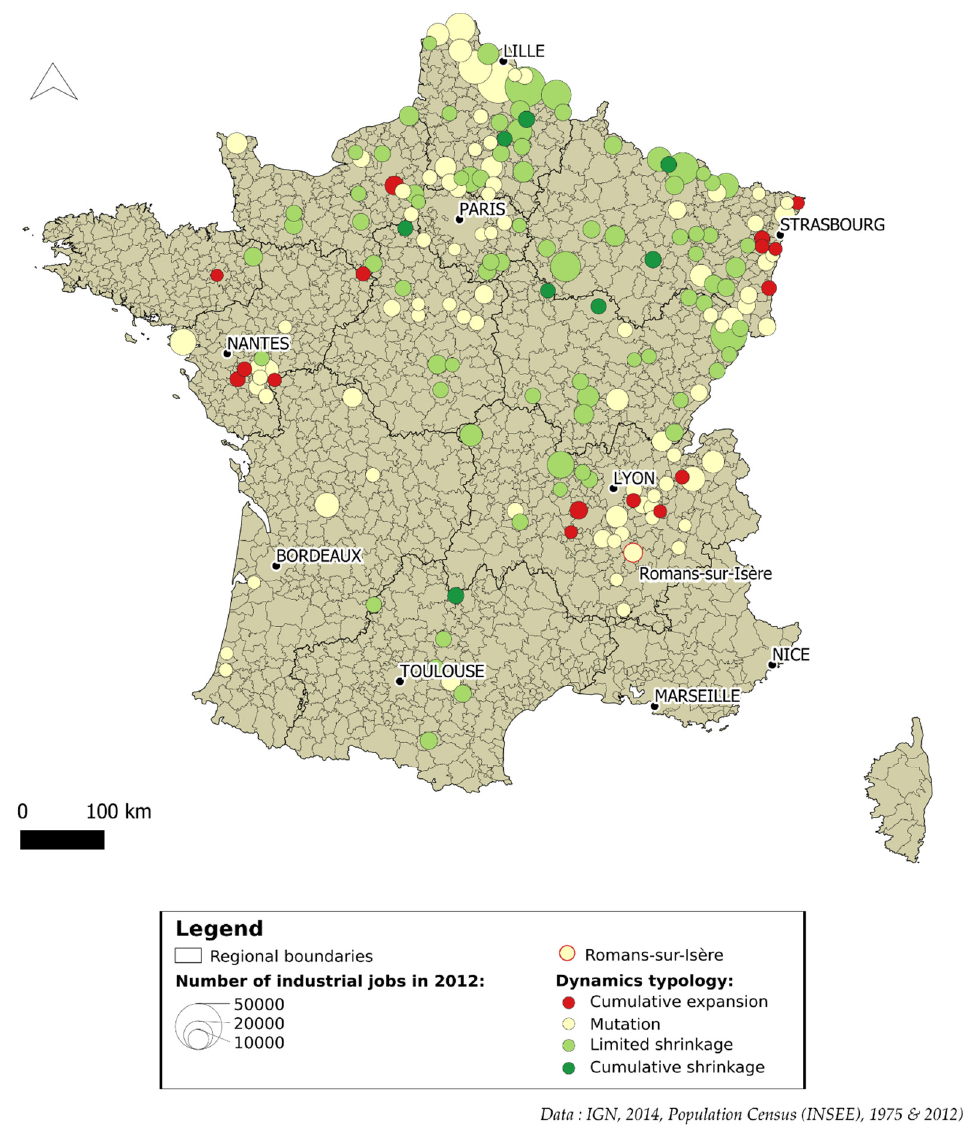
Figure 2. Typology of French medium-sized industrial towns’ dynamics (source: Authors).